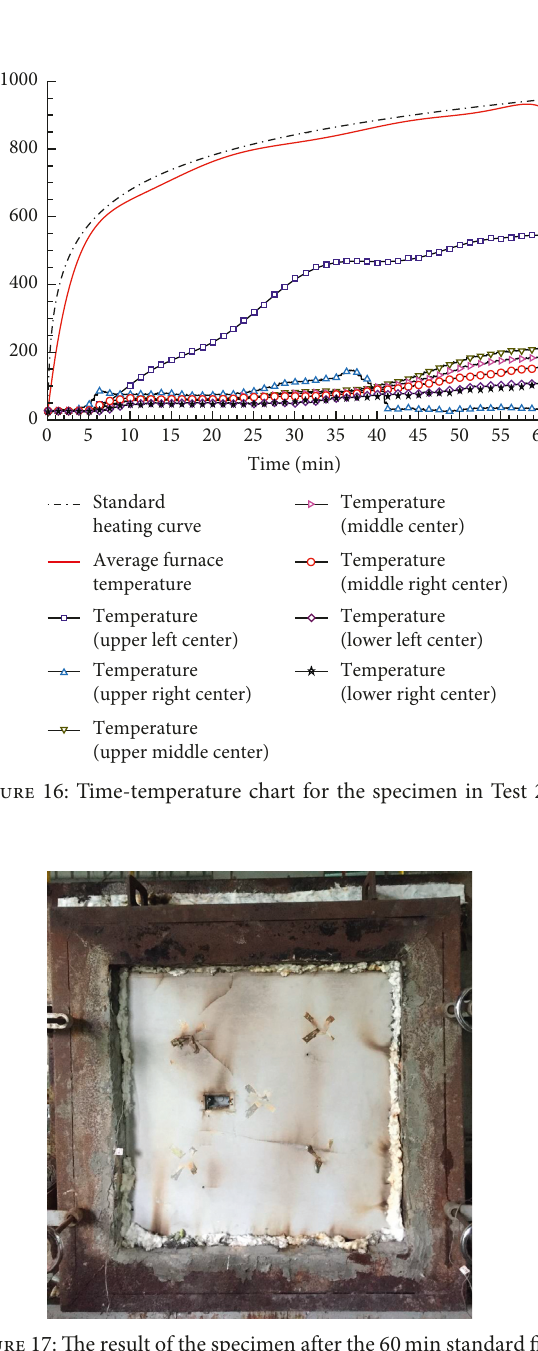
Figure 17: The result of the specimen after the 60min standard fire test in Test 2.